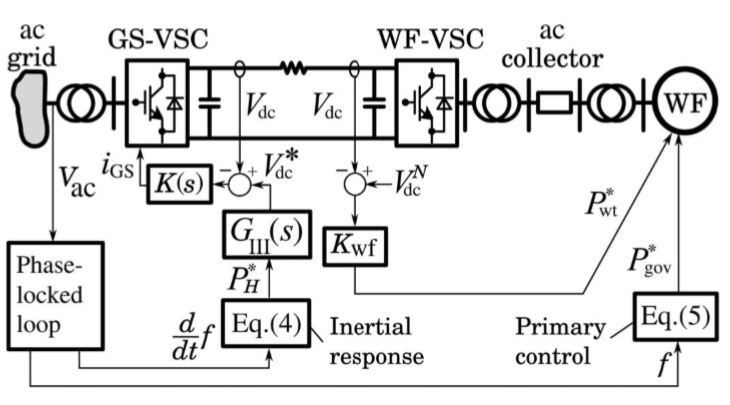
Figure 8. A diagram of the proposed controller infrastructure proposed in